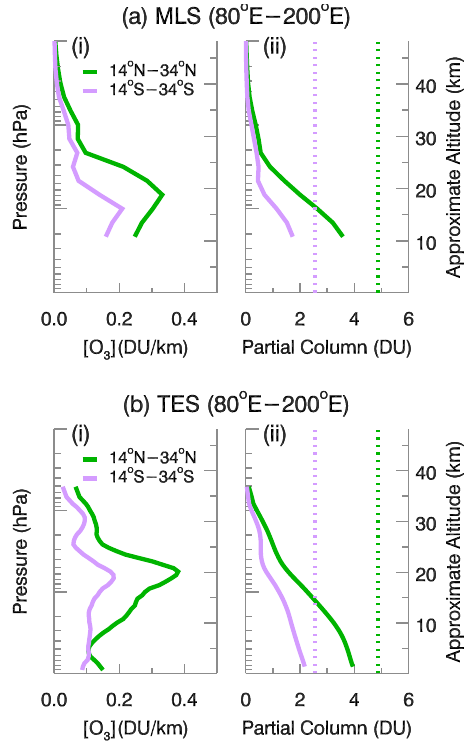
Fig. 6. (a) (i) Regional MJO variability of O 3 concentration (in unit of DU km − 1 ) derived from MLS measurements in regions (80 ◦ E–200 ◦ E, 14 ◦ N/S–30 ◦ N/S), which are enclosed by the rectangular boxes in Fig. 5. As in Fig. 5, the variability is defined as 2 standard deviations of the MJO cycle; (a) (ii) Regional MJO variability of partial O 3 columns integrated from 30 hPa to pressure levels below. (b) Same as (a) except for TES.